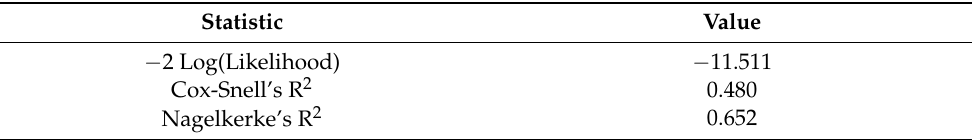
Table 3. Multivariate logistic regression goodness-of-fit